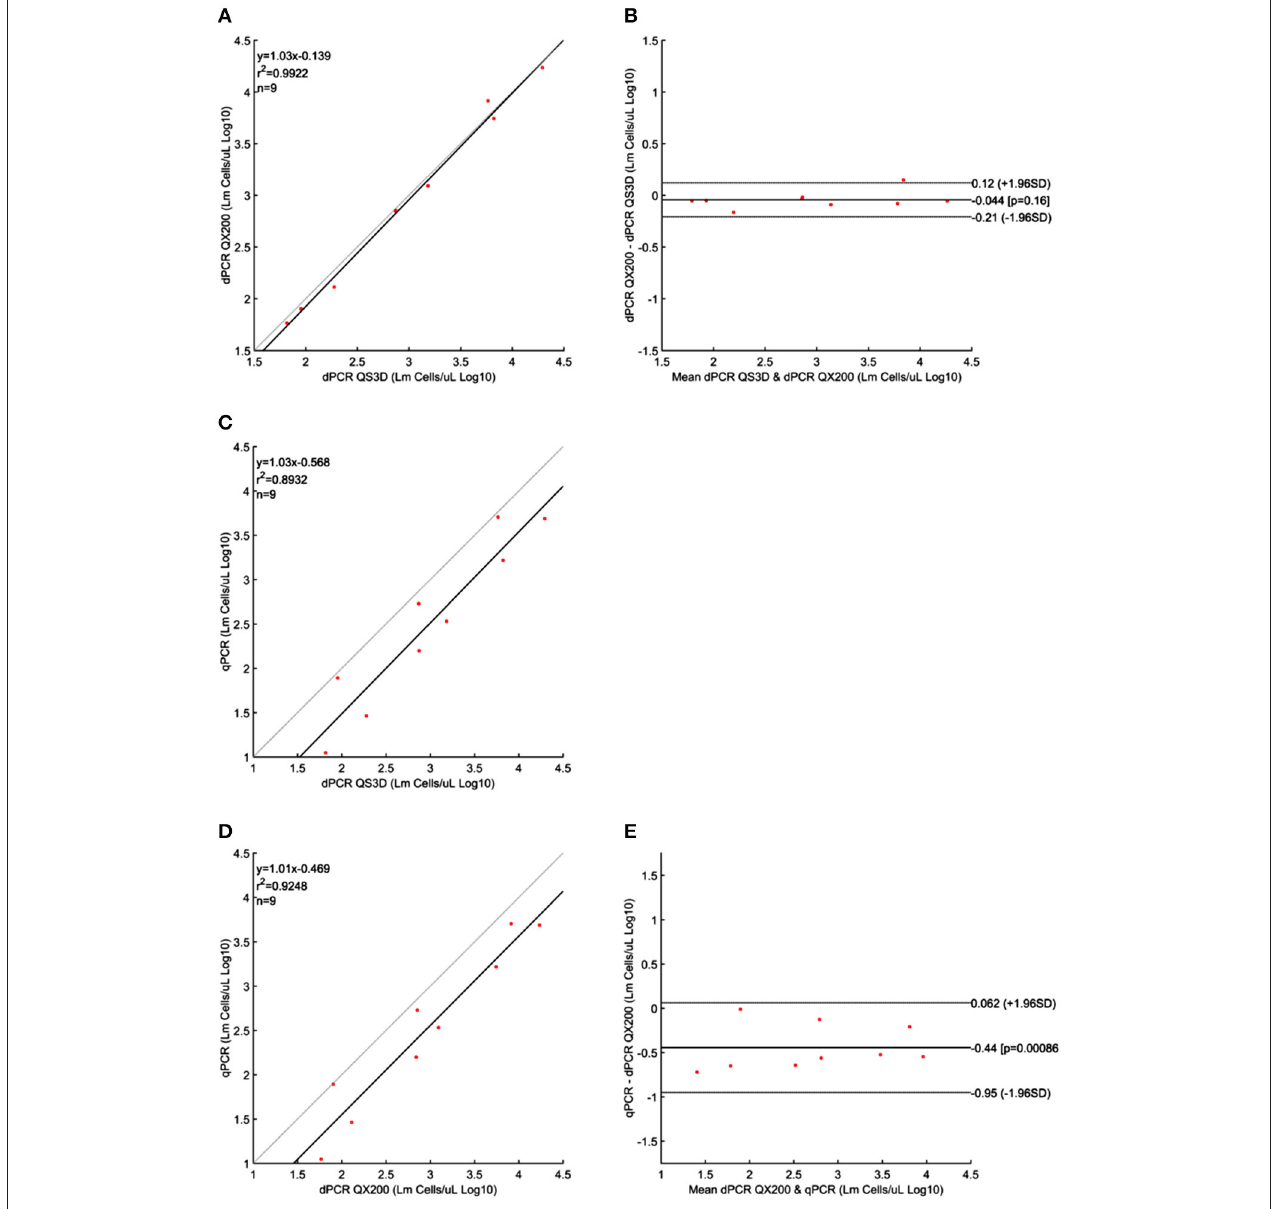
FIGURE 3 | Linear regressions and Bland and Altman analyses of L. monocytogenes (Lm) cells in unknown samples obtained by dPCRs (QuantStudio 3D and QX200) and qPCR. (A) Linear regression between the two dPCRs; (B) Bland and Altman analysis between the two dPCRs; (C) Linear regression of dPCR QuantStudio 3D and qPCR; (D) Linear regression of dPCR QX200 and qPCR; (E) Bland and Altman analysis of dPCR QX200 and qPCR. Bland and Altman analysis between QuantStudio 3D and qPCR was not possible because the differences were not normally distributed. Data were reported as Log 10 cells per µ L. The gray lines in linear regression plots represent the ideal regression